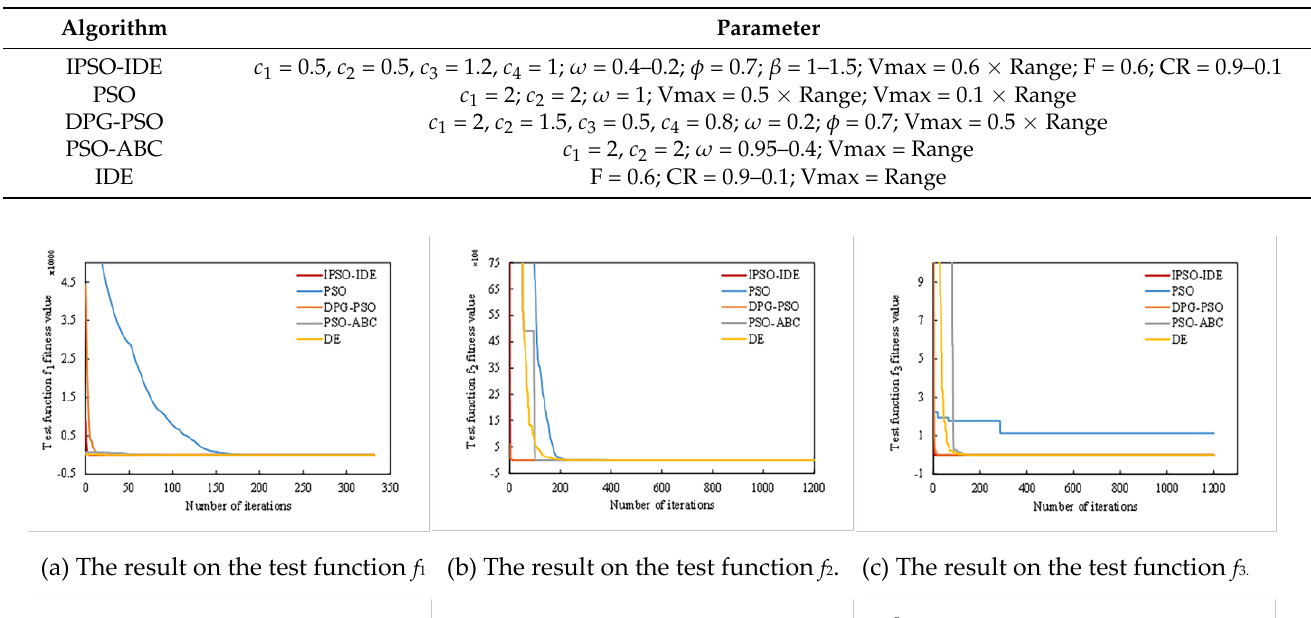
Table 2. Parameter settings of the different test algorithms (meaning of the symbols are provided in the respective literates).